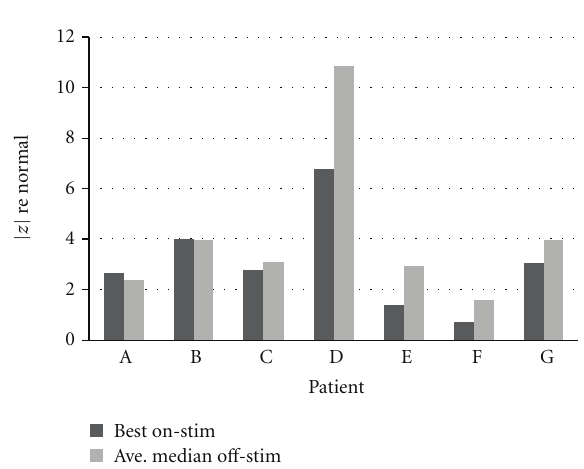
Figure 7: E ff ect of DBS on speech: best